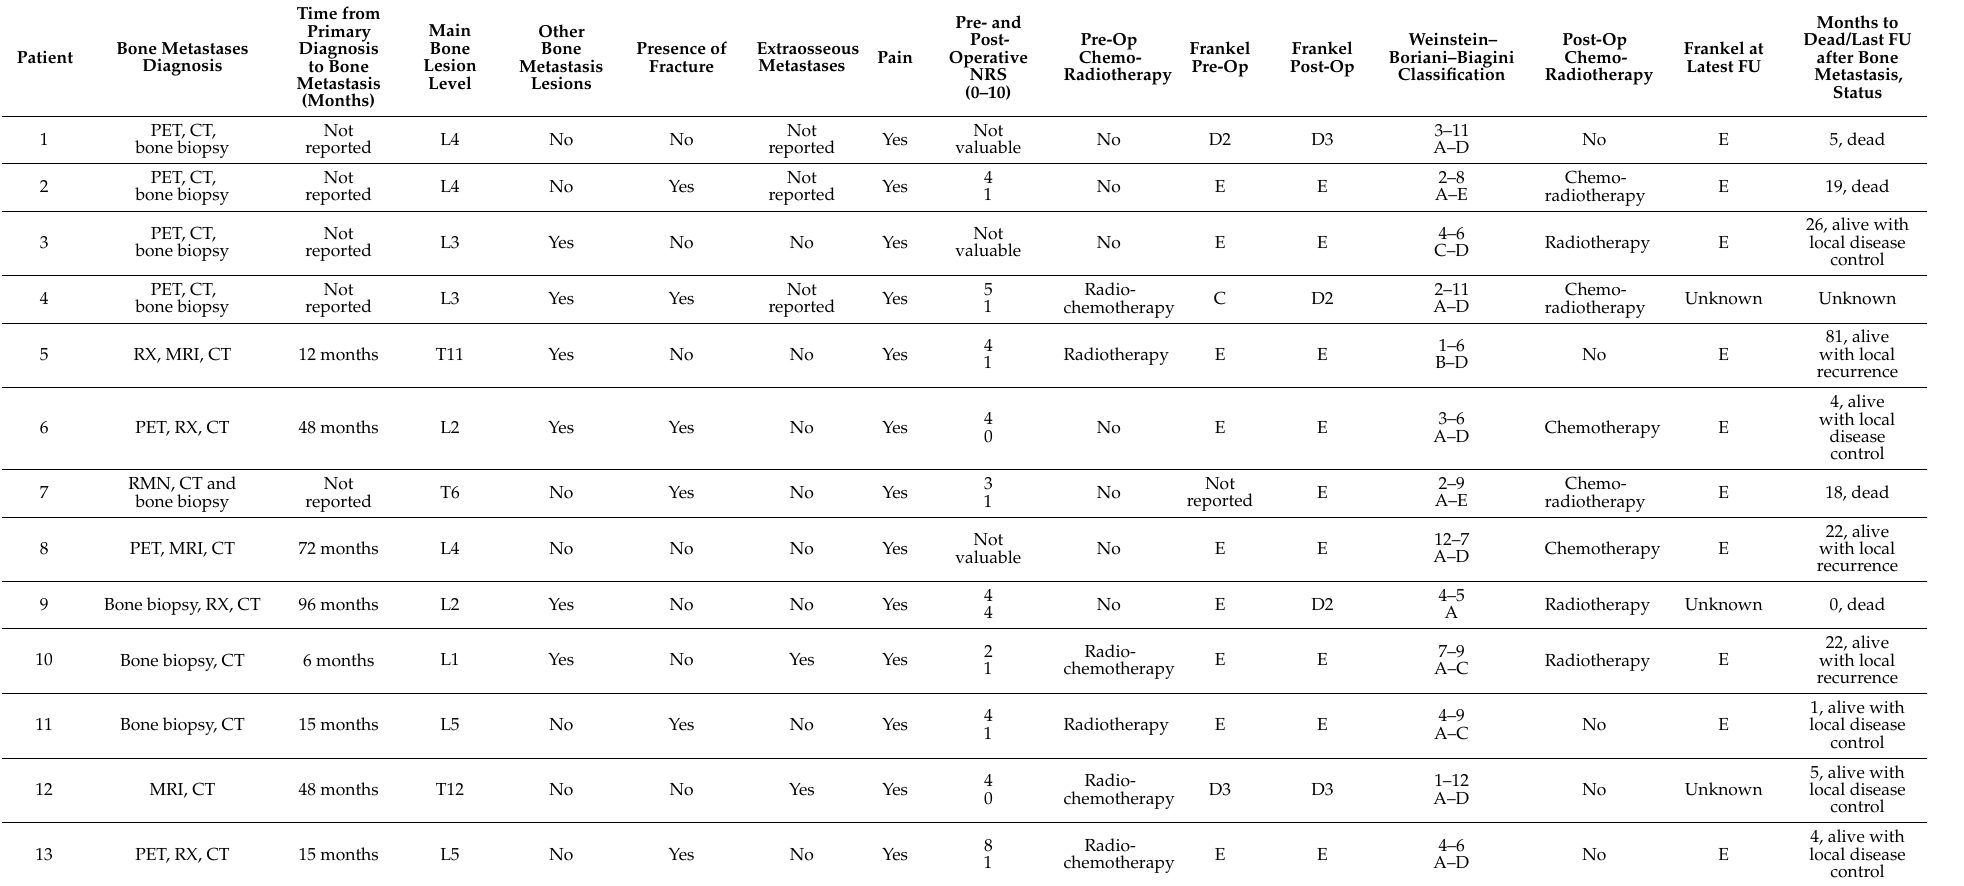
Table 2. Clinicopathologic characteristics of bone metastasis from endometrial